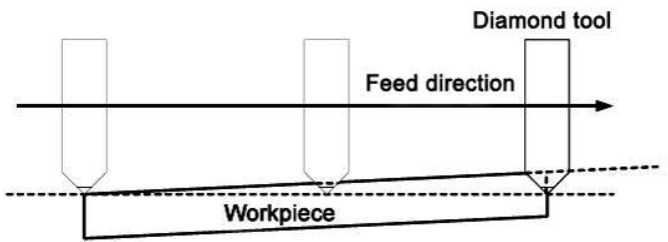
Figure 2. Schematic diagram of plunge-cutting